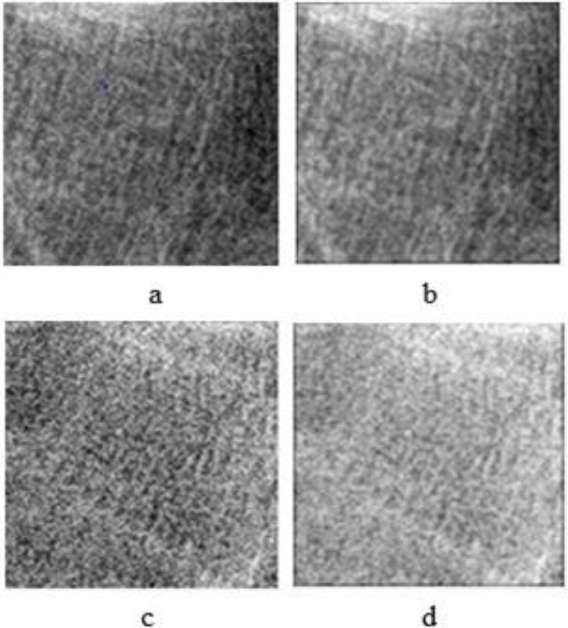
Figure 4. Filtering. Original ROI from KL0 knee radiograph (a), filtered ROI from KL0 knee radiograph (b), original ROI from KL2 knee radiograph (c), filtered ROI from knee radiograph of KL2